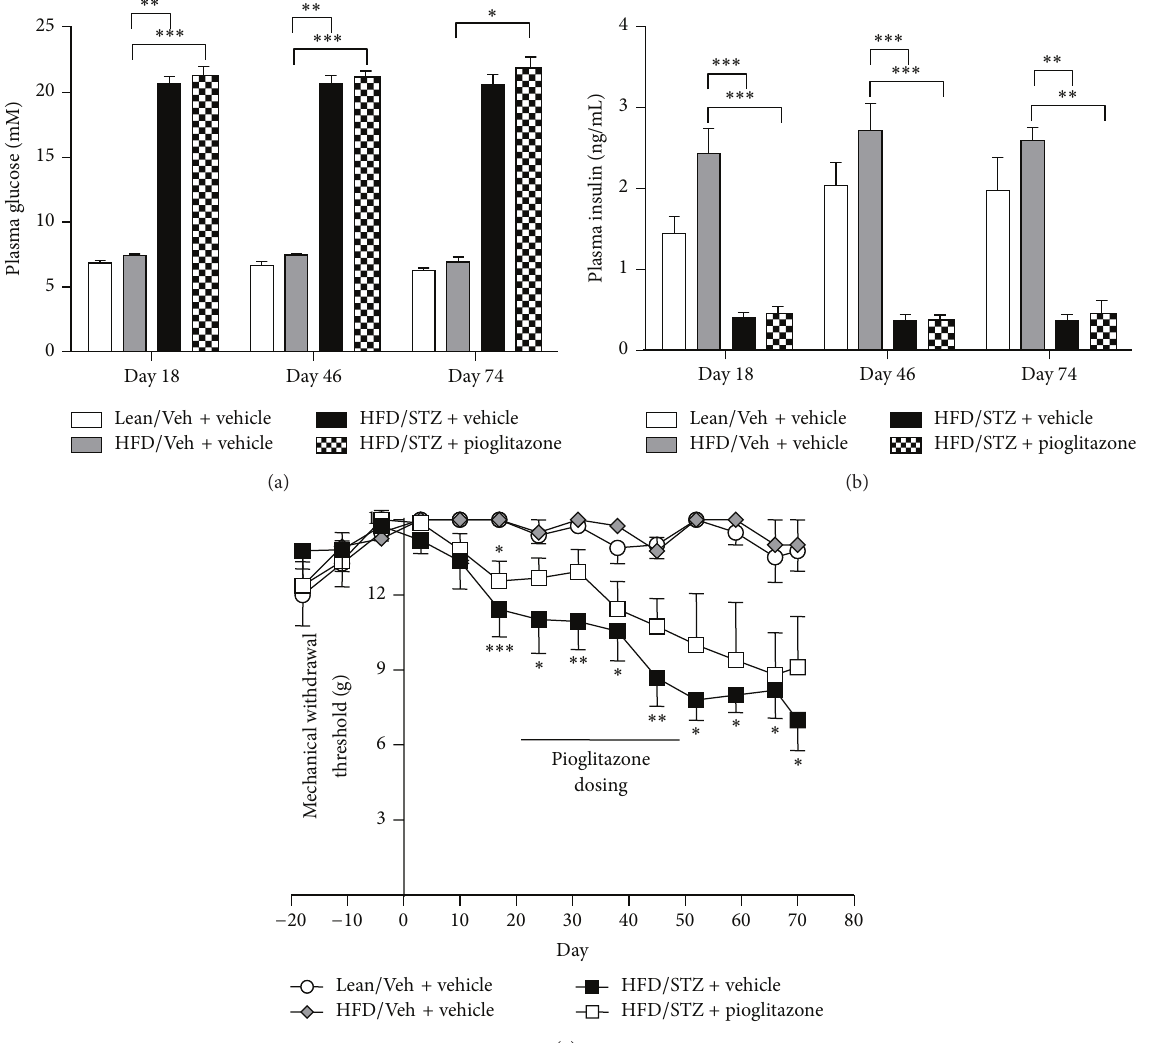
Figure 5: Effects of pioglitazone on metabolic changes and pain behaviour in HFD/STZ rats. Effects of pioglitazone treatment (10mgkg −1 , p.o.) versus vehicle from day 21–49, on (a) plasma glucose, (b) plasma insulin, and (c) hindpaw mechanical withdrawal thresholds in the HFD/STZ rat. Data are mean ± SEM. Group sizes day 0–49; Lean/Veh: 𝑛 = 11 ; HFD/Veh: 𝑛 = 11 ; HFD/STZ + vehicle: 𝑛 = 10 , HFD/STZ + pioglitazone: 𝑛 = 10 . Group sizes day 49 onwards; Lean/Veh: 𝑛 = 6 ; HFD/Veh: 𝑛 = 6 ; HFD/STZ + vehicle: 𝑛 = 5 ; HFD/STZ + pioglitazone: 𝑛 =